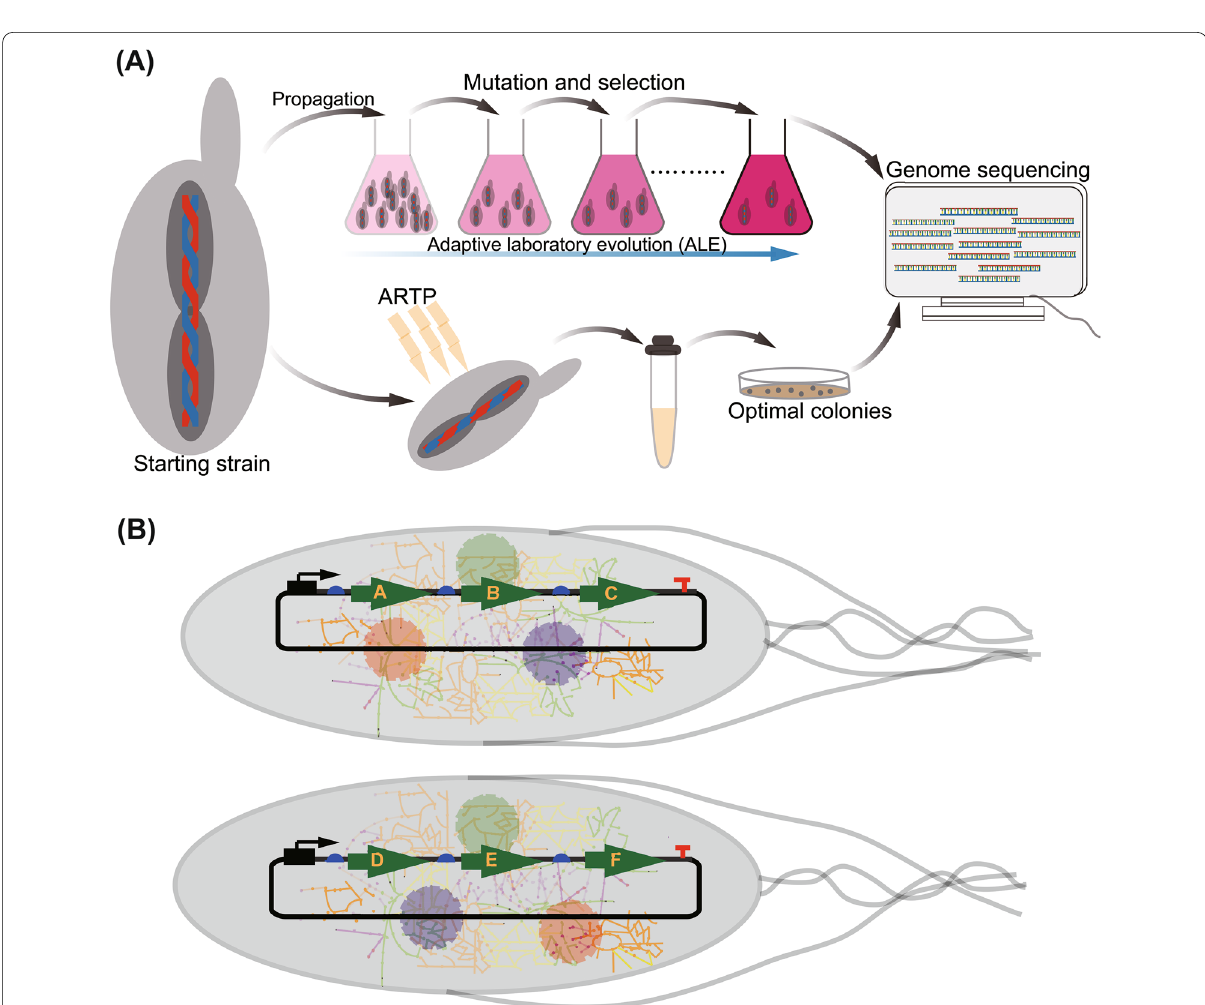
Fig. 5 Schematic illustration of adaptive laboratory evolution (ALE), atmospheric and room‑temperature plasma (ARTP), and modular co‑culture. A Microorganisms are exposed to a desired selective mechanism and or environment for an iterative period enabling natural selection to optimize variants with enhanced fitness. Genome sequencing and transcriptome can be used to analyze mutant variants. B Modular co‑culture engineering. Segregating pathway into modules ensures a holistic assessment of each part for efficient optimization and